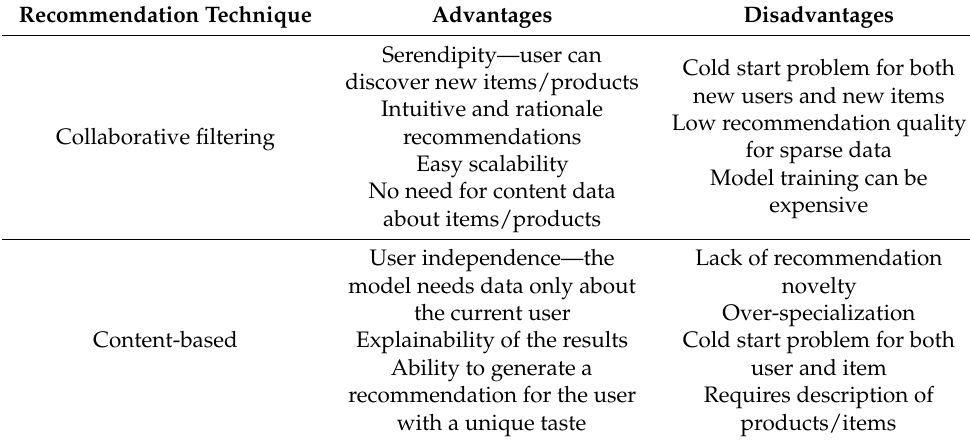
Table 1. Main recommendation techniques—advantages and disadvantages. Recommendation